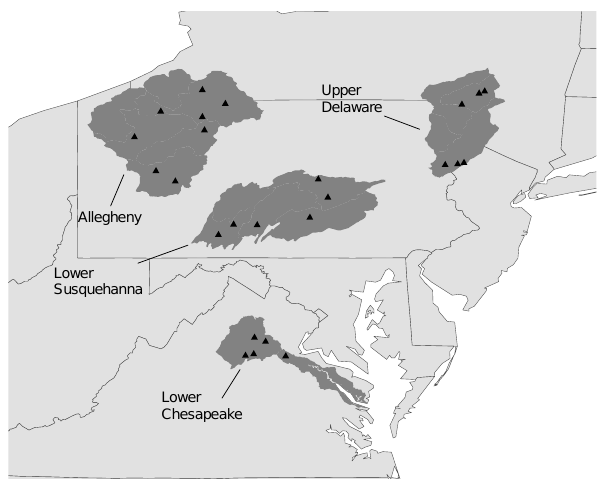
Fig. 1. Four River basins and the 25 nested catchments in northeast United